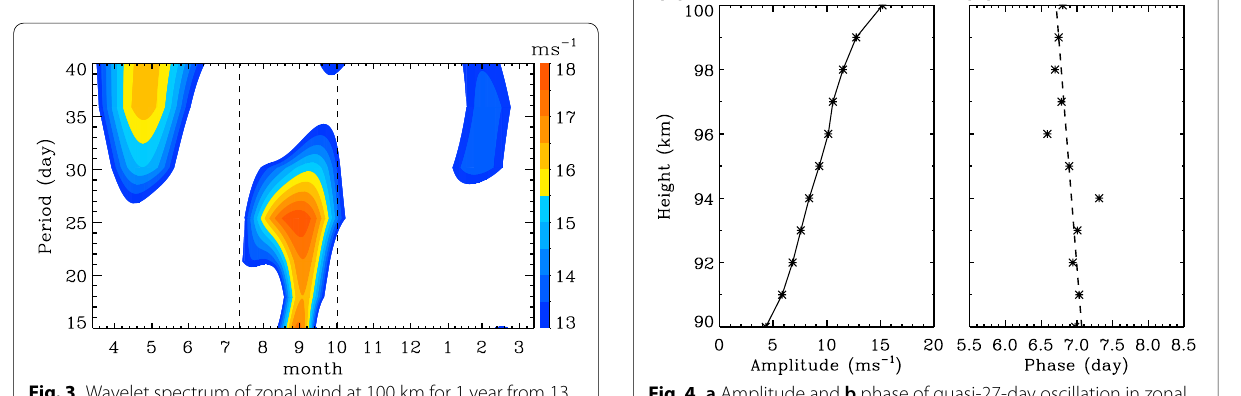
Fig. 4 a Amplitude and b phase of quasi-27-day oscillation in zonal wind from Maui meteor radar observation. The asterisk denotes the values derived from the sinusoidal wave fitting, and the dashed line in b denotes the linearly fitted